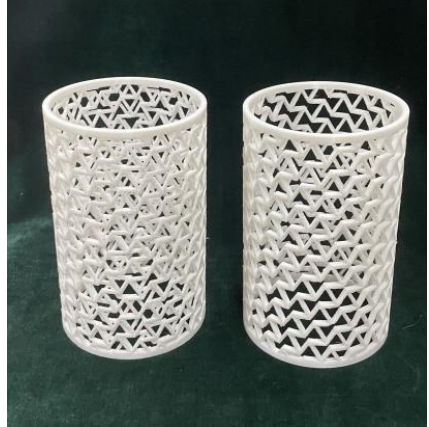
Figure 6. 60° RHCS and [60°/ − 60°] RHCS. Figure 6. 60 ◦ RHCS and [60 ◦ / − 60 ◦ ]